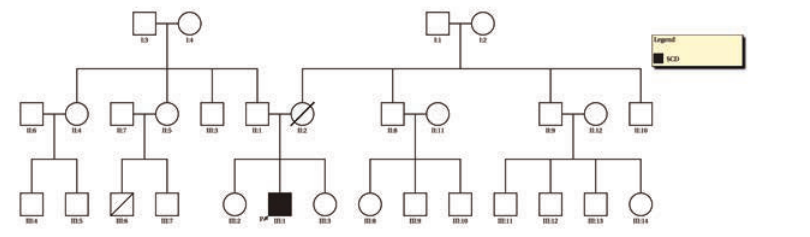
Figure 3. Pedigree of the family. The black arrow indicates the proband. Deceased family members are represented with single slanted line